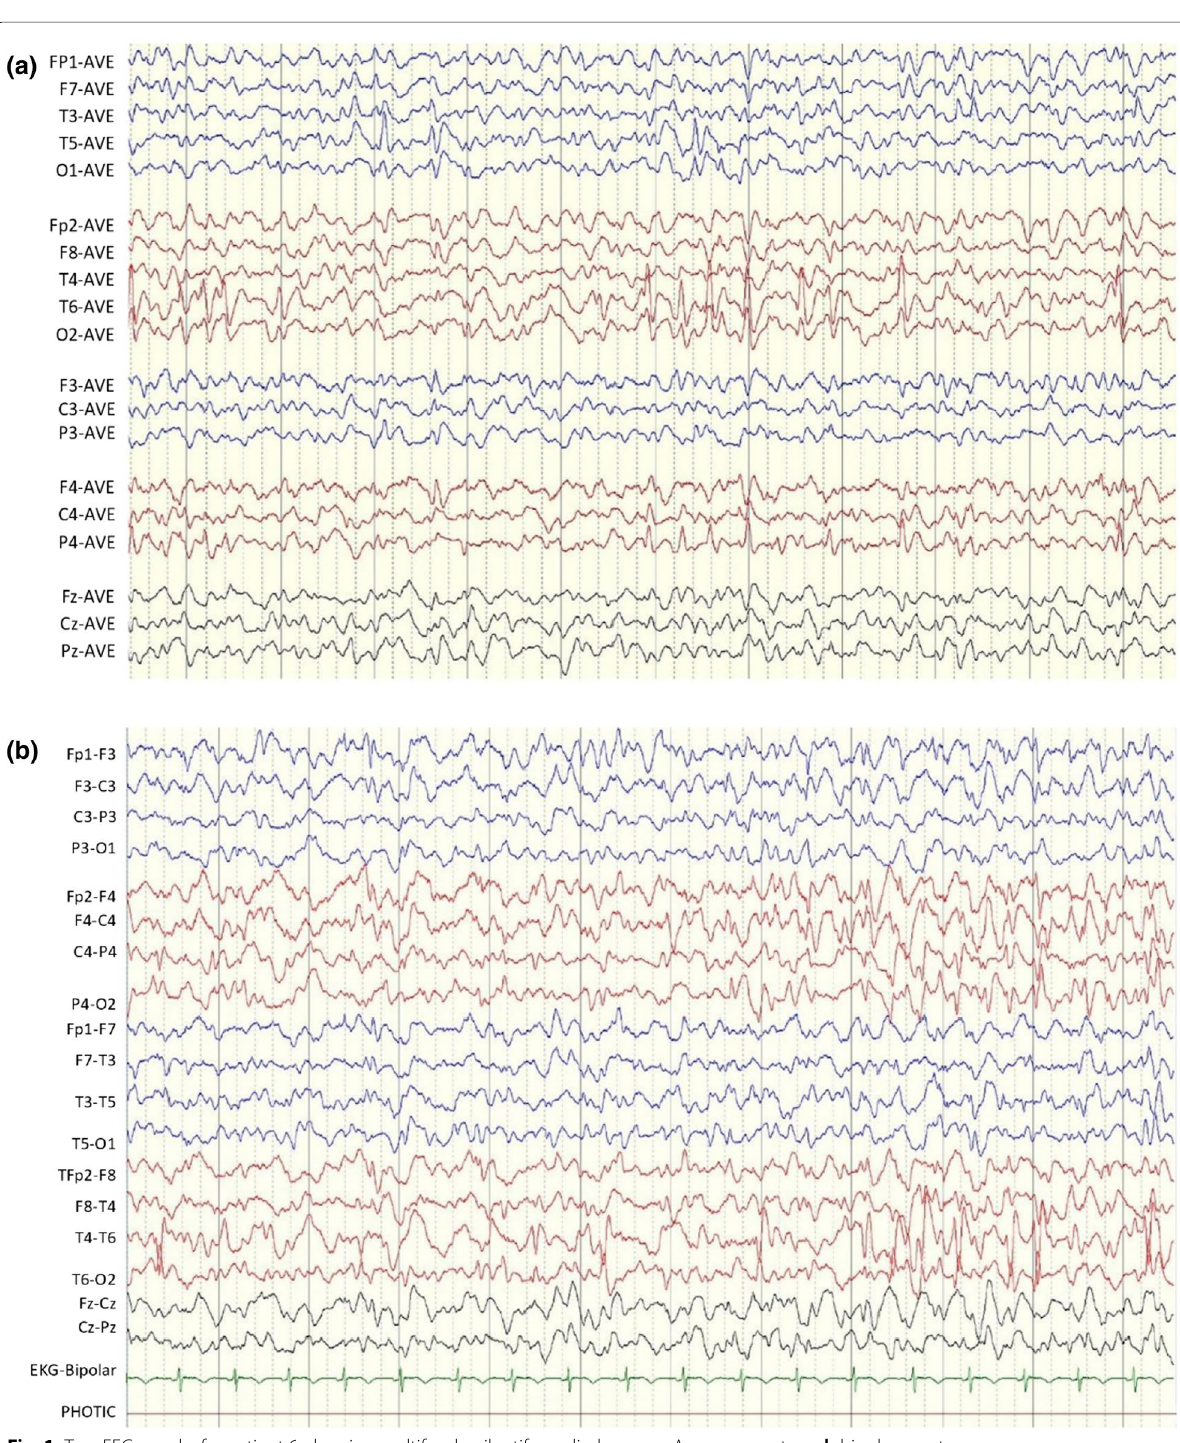
Fig. 1 Two EEG epochs for patient 6, showing multifocal epileptiform discharges. a Average montage, b bipolar